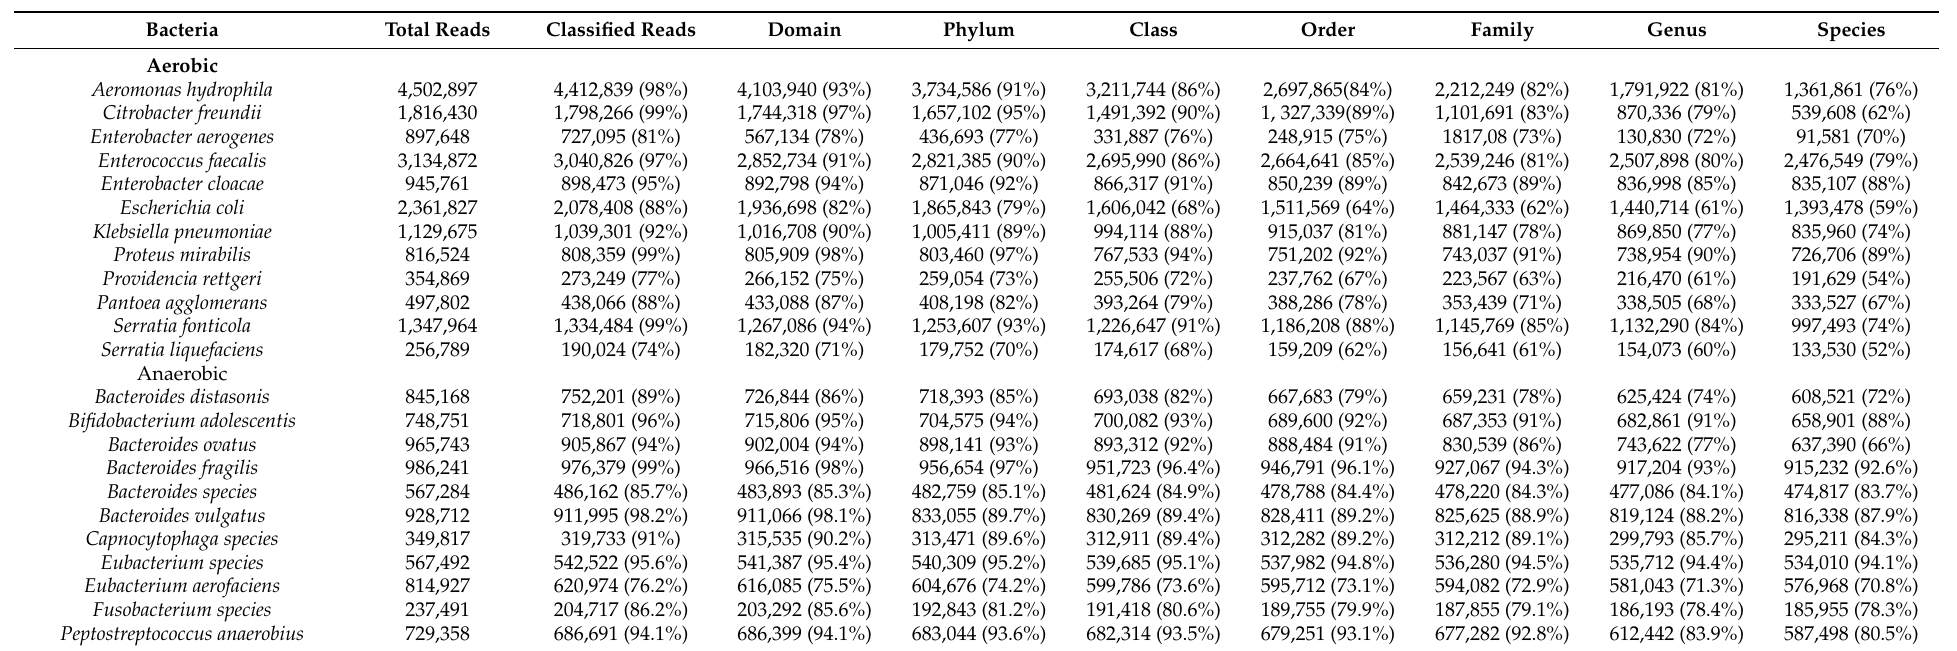
Table 1. Metagenomic identification of the aerobic and anaerobic beta-lactam resistant bacteria isolated from feces cultures of humans in healthy conditions.